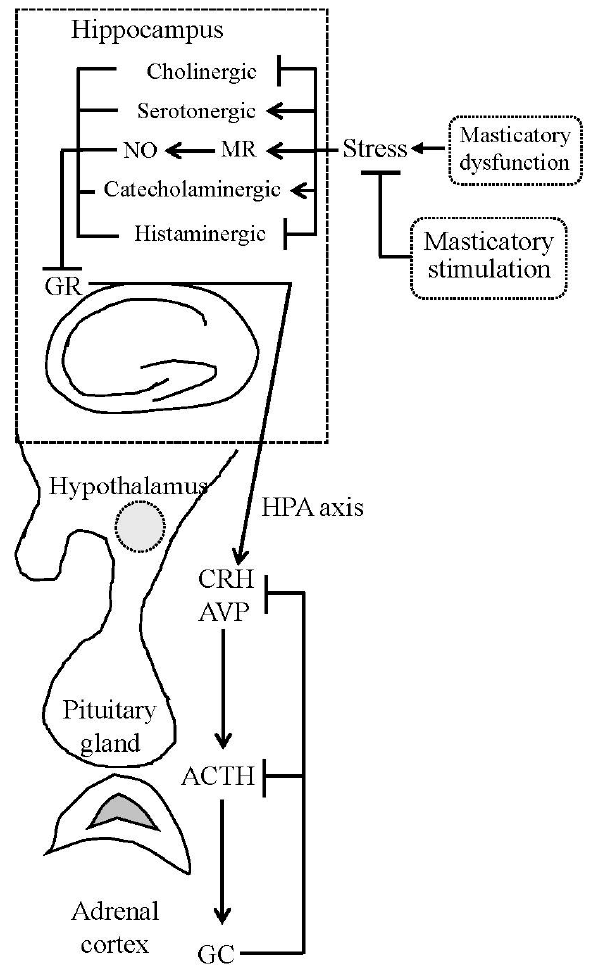
Figure 1. Simplified diagram showing the relationship between mastication, the hippocampus, and hypothalamic-pituitary-adrenal (HPA) axis activity. Masticatory dysfunction, acting as a stressor, suppresses hippocampal choline and histamine levels, and elevates catecholamine, serotonin, nitric oxide (NO) levels, and mineralocorticoid receptor (MR) expression, and then reduces the hippocampal glucocorticoid receptor (GR) expression, leading to hypersecretion of hypothalamic corticotropin-releasing hormone (CRH) and arginine vasopressin (AVP), and HPA axis hyperactivity. Masticatory stimulation suppresses the hyperactivity of the HPA axis and thus ameliorates stress-induced disorders. ACTH, adrenocorticotrophic hormone; GC, glucocorticoid. Nitric oxide (NO) is produced by nitric oxide synthase (NOS), including endothelial NOS, inducible NOS, and neuronal NOS (nNOS), which is the main form expressed in the brain, localized to the sites of neuronal proliferation and migration in the hippocampal dentate gyrus and forebrain